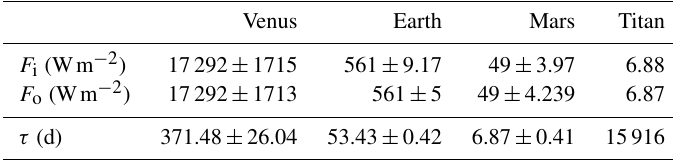
Table 4. Fluxes of energy and residence times in planetary atmospheres.